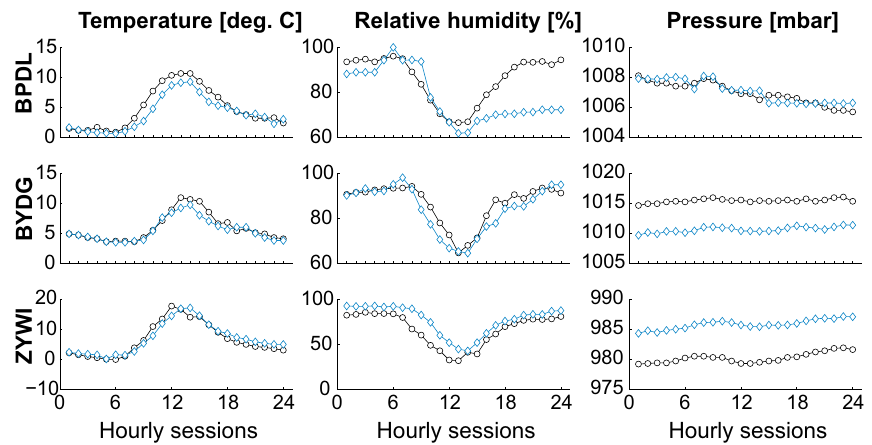
Fig. 4. Measured (black circles) and interpolated (blue diamonds) meteorological parameters for three stations: BPDL, BYDG, ZYWI on 7 November